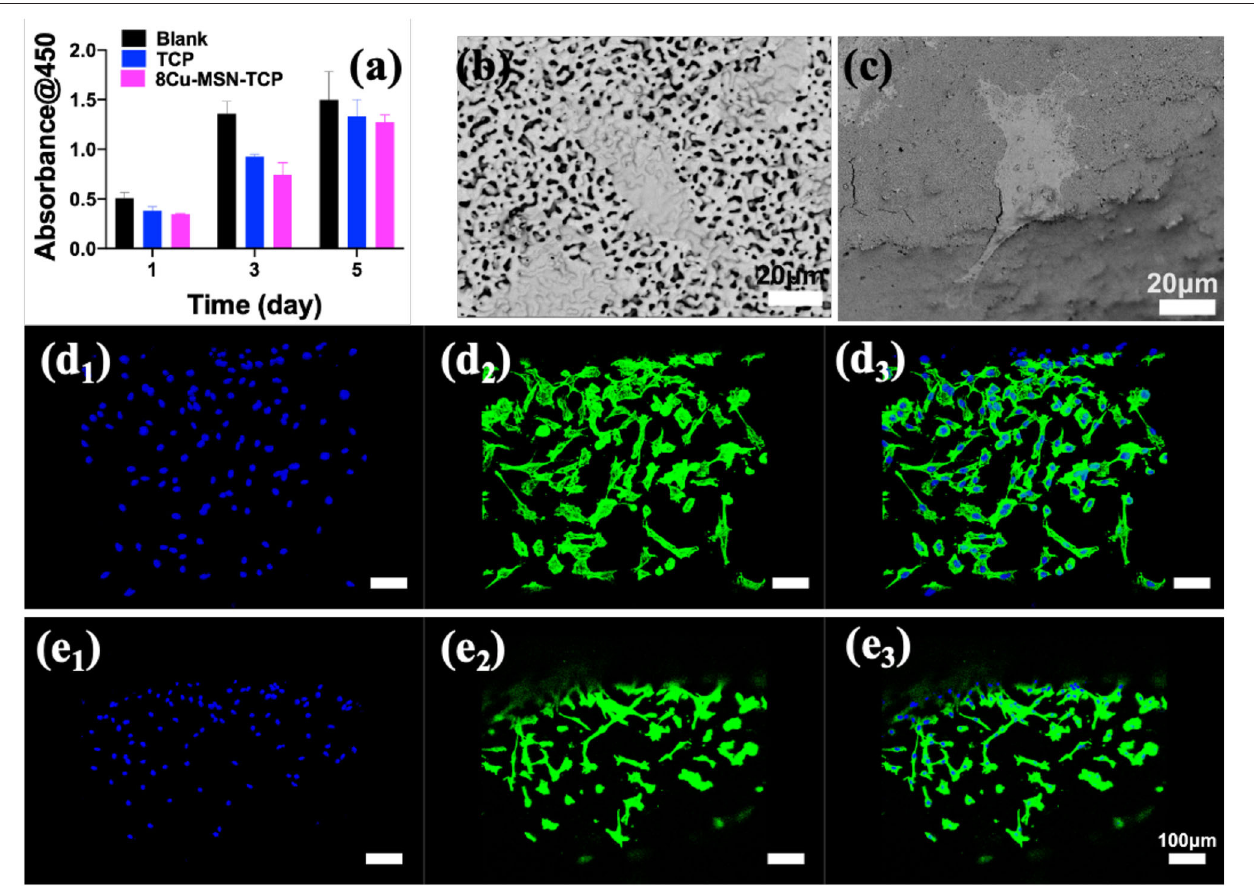
FIGURE 6 | The viability of rabbit bone marrow-derived mesenchymal stem cells in β -TCP and 8Cu-MSN-TCP scaffolds for 1, 3, and 5 days (a) ( n = 3). Scanning electron microscopy (b,c) and confocal microscopy images of nucleus (d 1 ,e 1 ) , cytoskeleton (d 2 ,e 2 ) and merged mode (d 3 ,e 3 ) of rBMSCs of rBMSCs in β -TCP (b,d) and 8Cu-MSN-TCP scaffolds (c,e) , suggesting that 8Cu-MSN-TCP scaffolds had satisfactory biocompatibility.